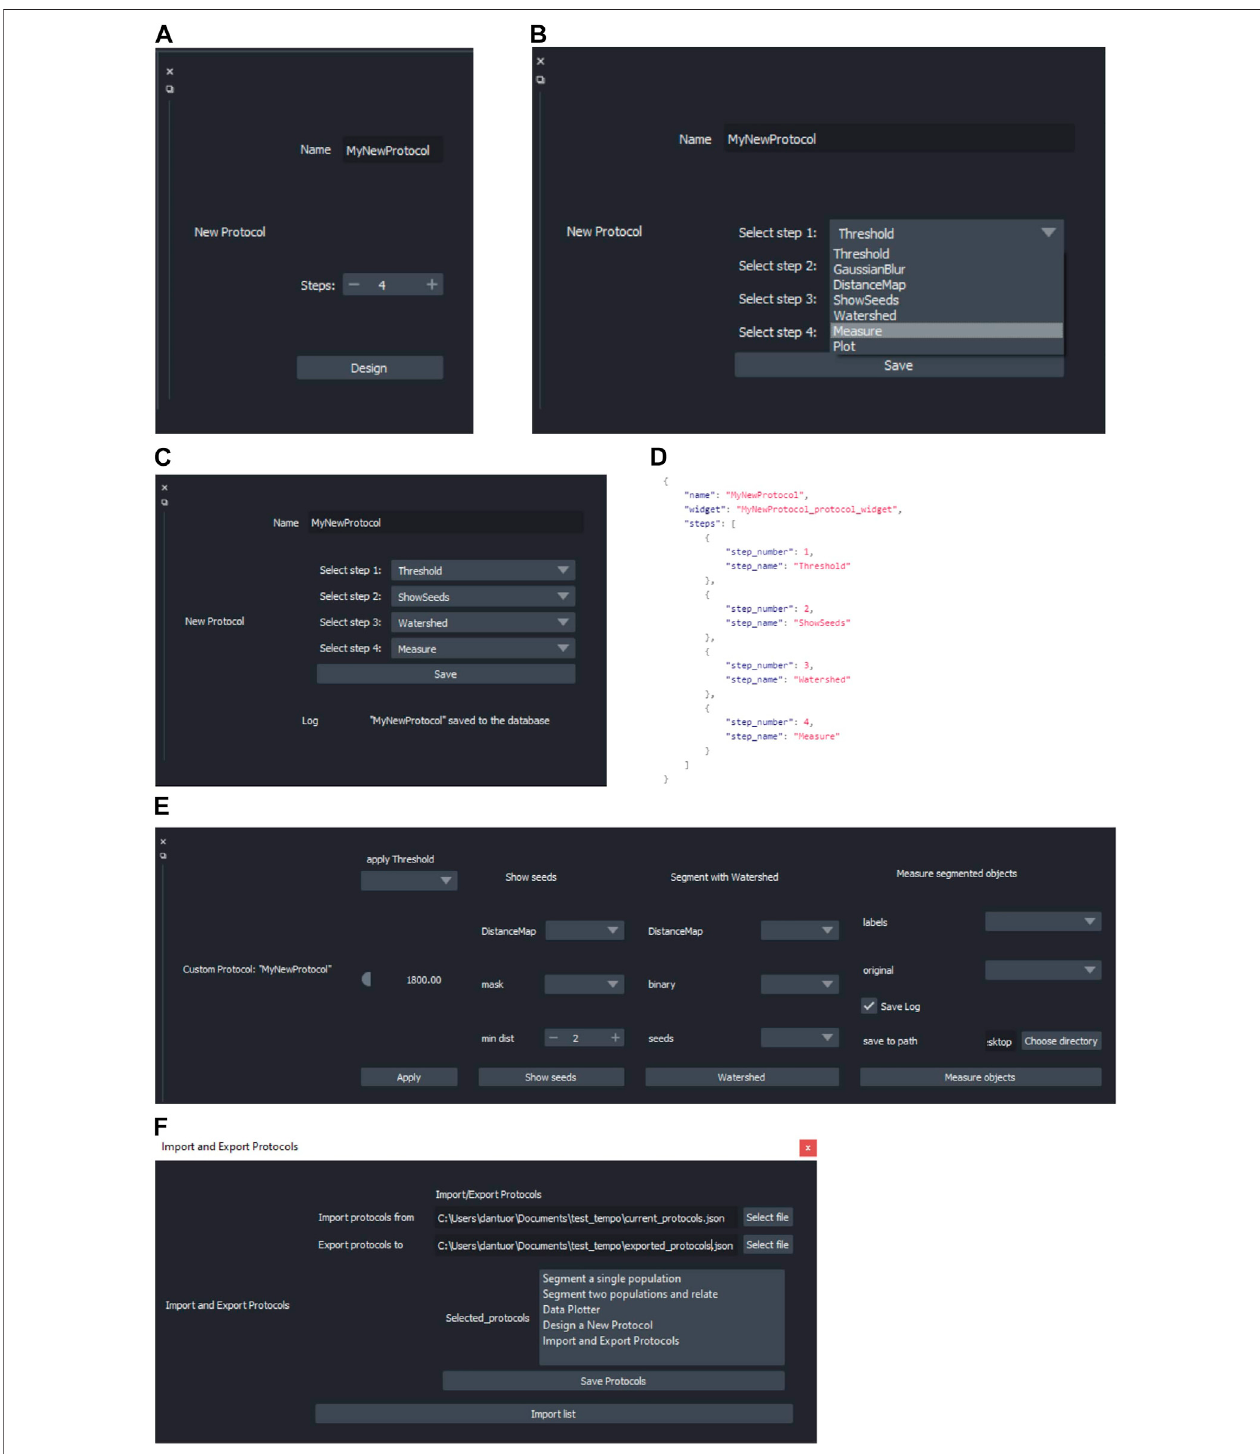
FIGURE 3 | Design of a custom image analysis work fl ow with ZELDA without requiring any scripting knowledge. (A) Choice of the number of steps for the new protocol to implement a custom image analysis work fl ow. (B) Drop-down menu showing all the modules implemented in ZELDA. (C) Assignment of an operation to a speci fi c step of the new protocol. (D) Example of updated JSON database that controls the software layout, once a new protocol is saved. (E) The newly created protocol GUI available after having restarted ZELDA. (F) “ Import and Export Protocols ” allows the user to import and export the content of the ZELDA .json database. Either a new fi le is created or protocols are appended to the destination database to easily share it with the community.